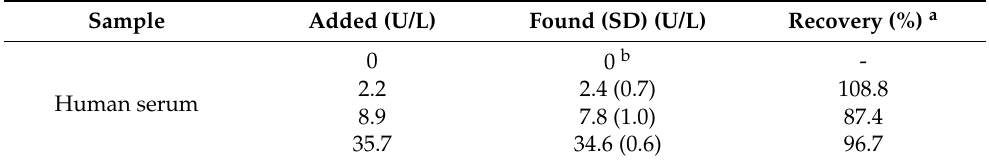
Table 2. Detection of AAO activity in normal human serum using the nanozyme-based colorimetric method ( n =